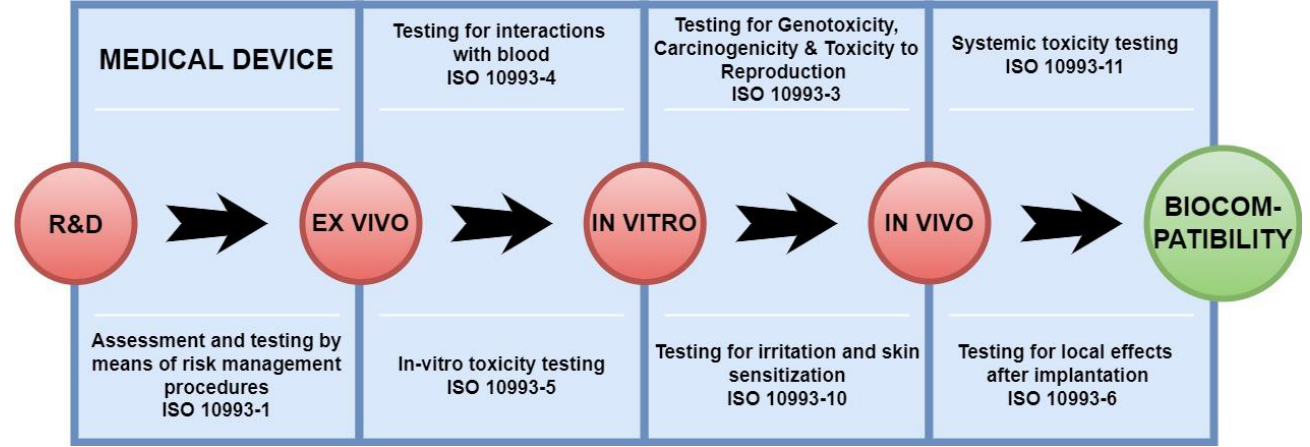
Figure 1. Schematic overview of the development process of medical devices.